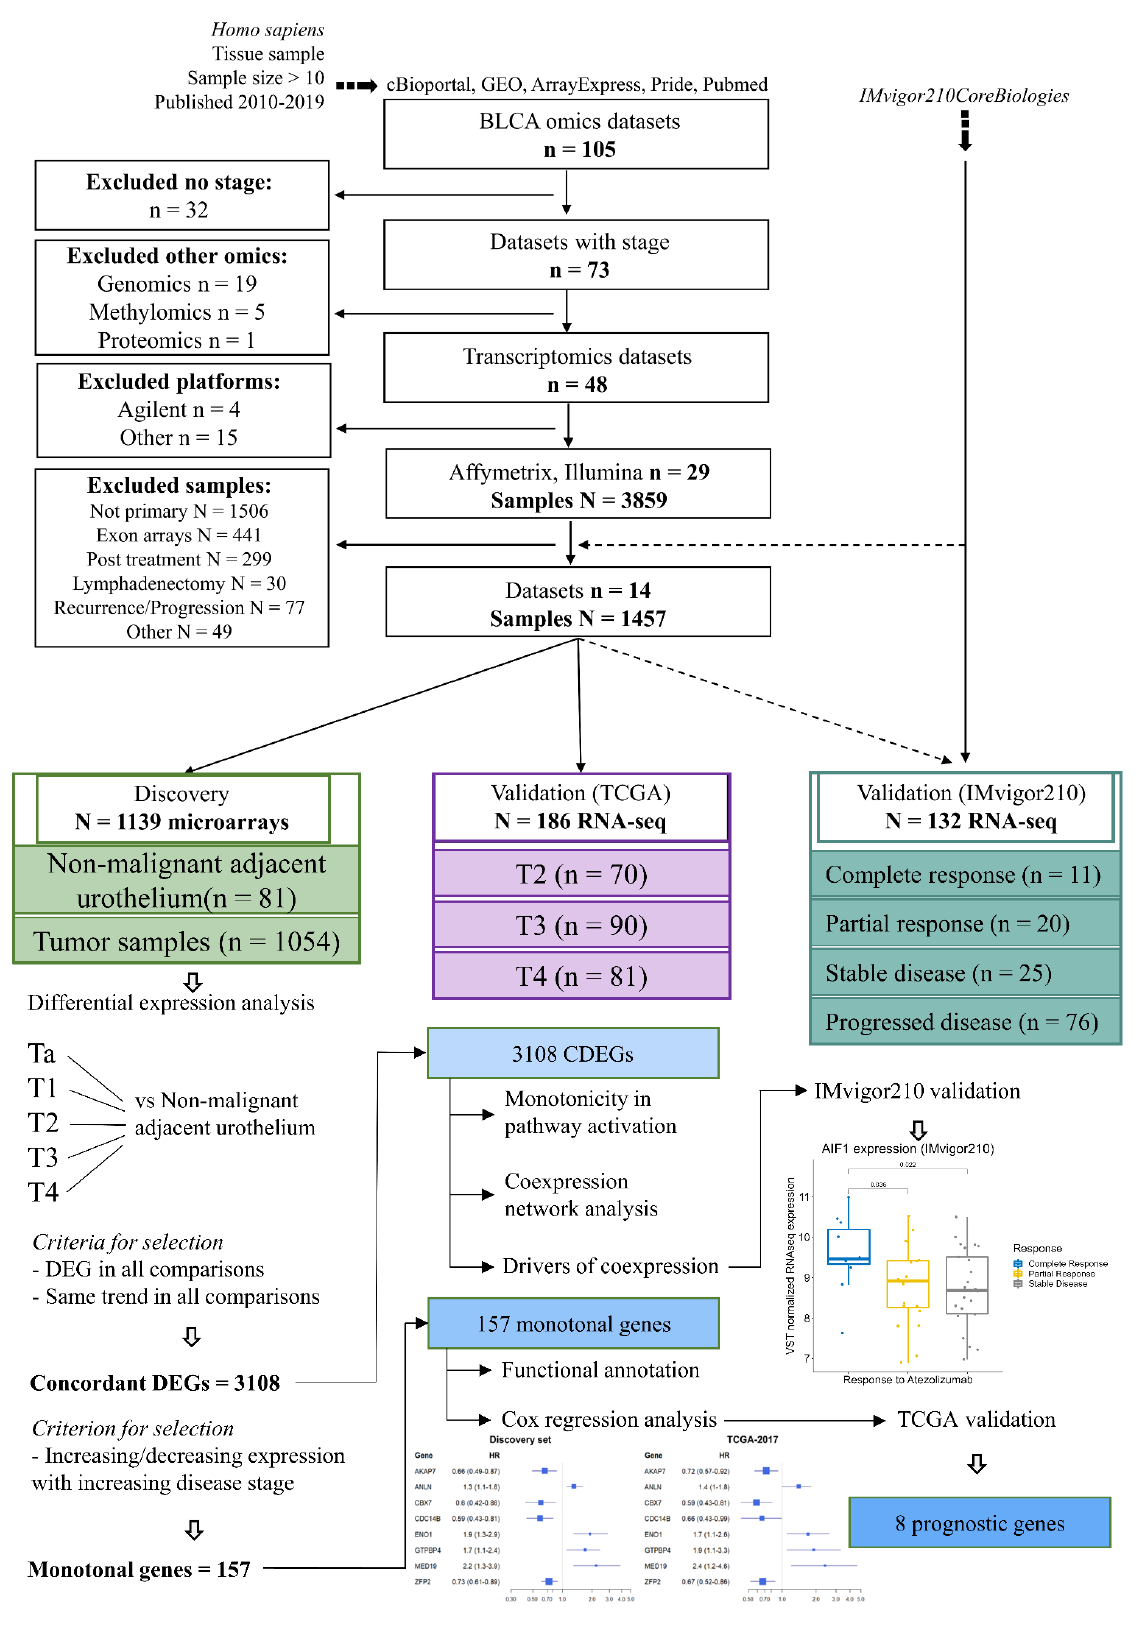
Figure 1. Study design and workflow for the analysis of the selected primary BLCA